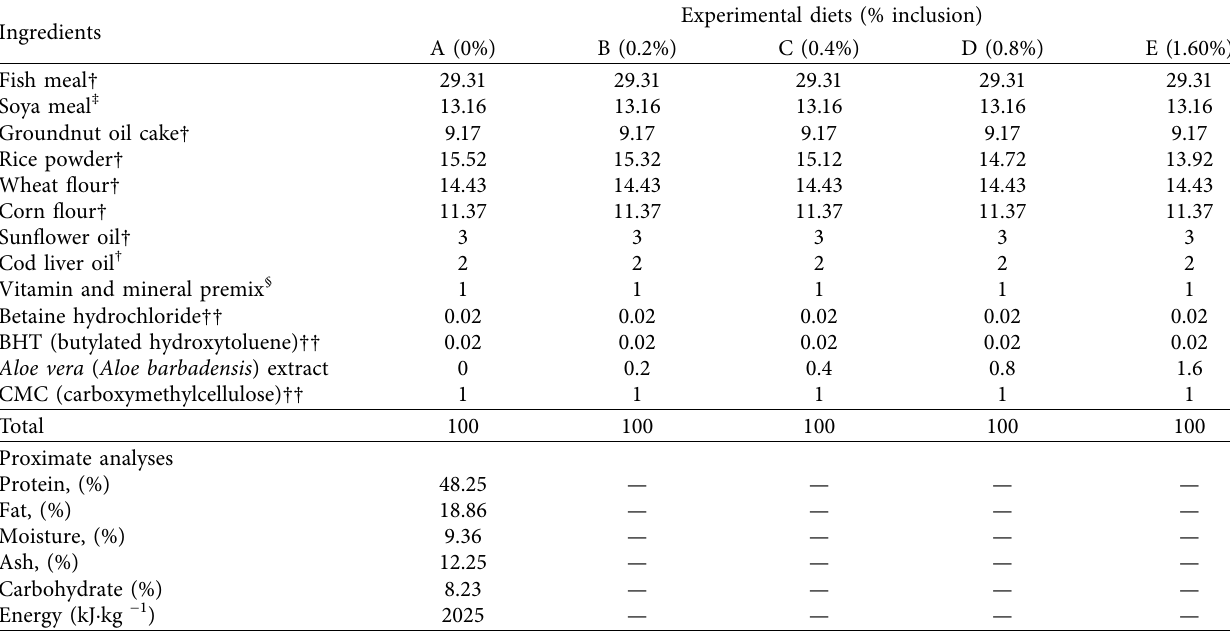
Table 1: Percentage of the experimental diets containing supplement of different levels of Aloe vera (gel extract) and proximate